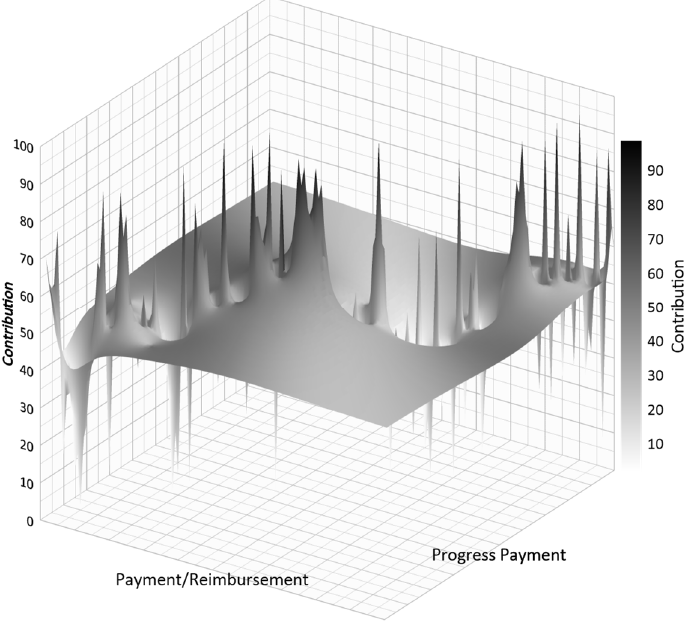
Figure 8. Interaction between “Payment/ Reimbursement” and “Misunderstanding the Contract”